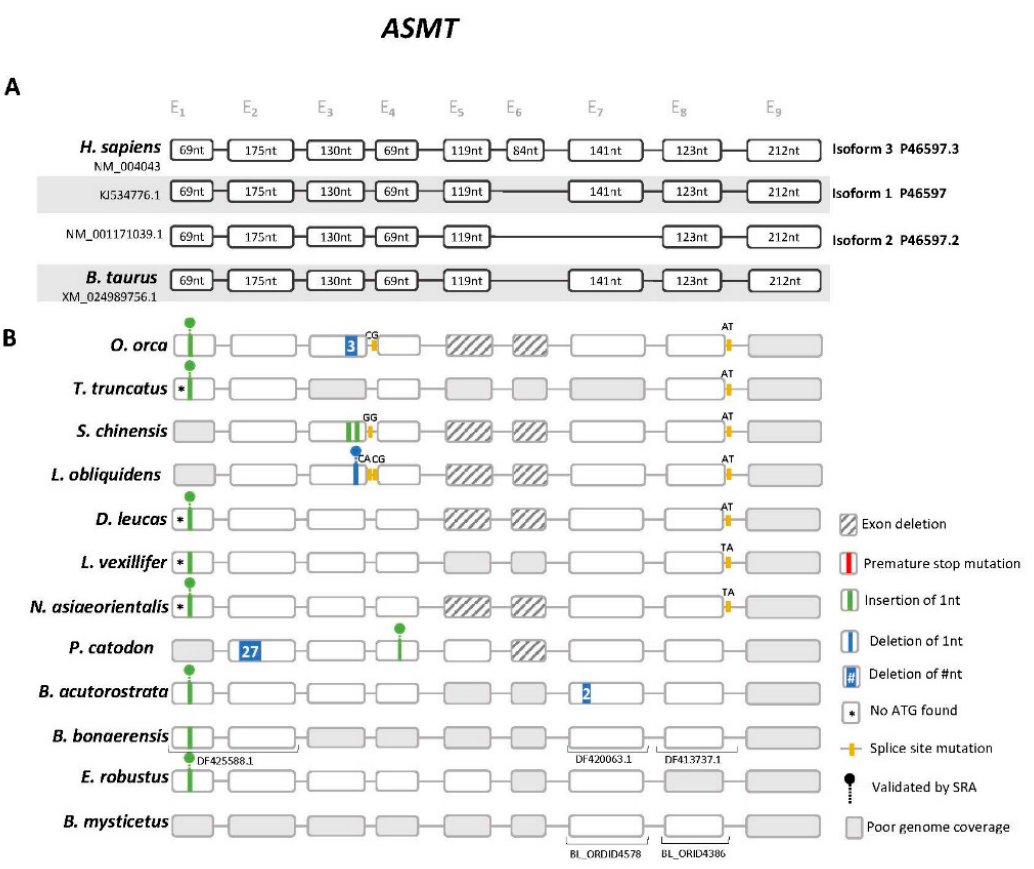
Figure 2. Asmt gene annotation. ( A ) Schematic representation of the gene structure and distinct isoforms of human and B. taurus Asmt gene (not to scale), each box represents an exon and lines represent intronic regions. ( B ) Schematic representation of the corresponding Asmt genes in Cetacea and location of the identified mutations. Non-canonical splice sites are indicated above the corresponding annotation.